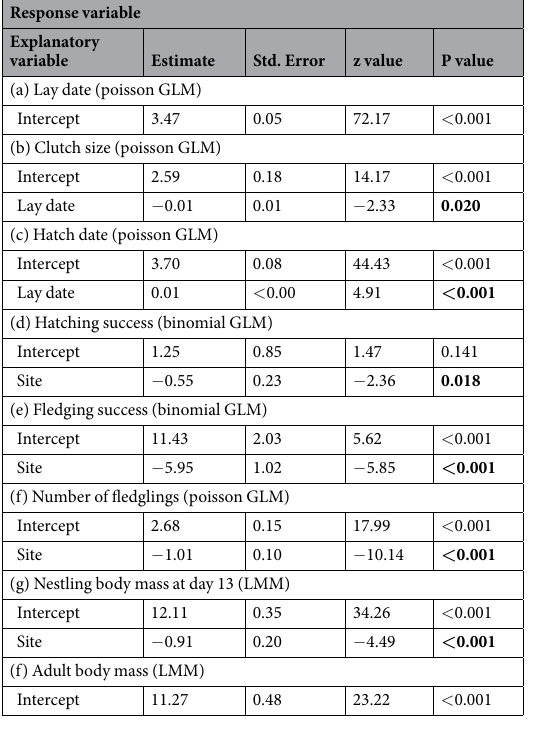
Table 3. Results from models (after backward selection) investigating how life history traits and body mass varied across the three study sites. Lay date, clutch size, hatch date and number of fledglings were modelled with a Poisson error structure, hatching success (number of hatchlings over laid eggs) and fledging success (number of fledglings over number of hatchlings), were modelled with a binomial error structure, while adult and nestling body mass were modelled with a Gaussian error structure in LMMs with nestbox included as random factor. Site was included in all models as main fixed effect, whereas date of first egg of each nest was included as covariate to control for seasonal variation in reproductive timing and body mass (except for the model testing for variation in lay date across sites). For adult body mass, sex was also included as fixed factor. These were dropped if not significant via backward selection (only significant variables are